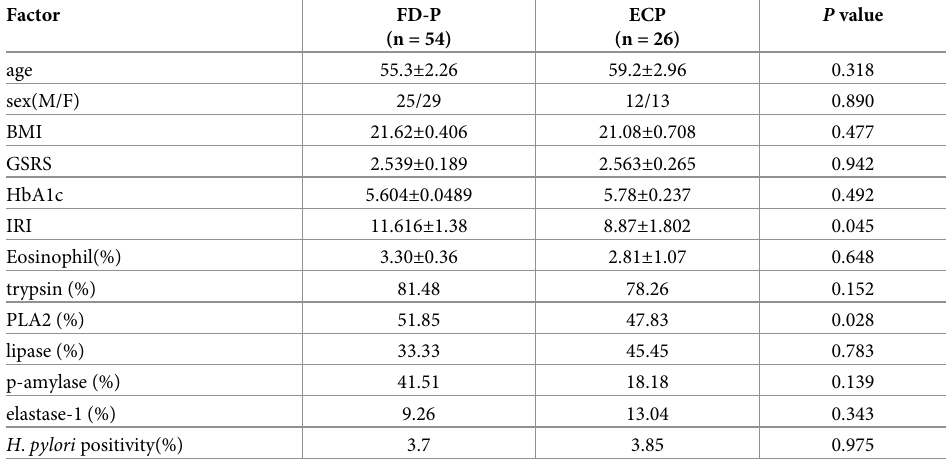
ECP: Early chronic pancreatitis, FD-P: Functional dyspepsia with pancreatic enzyme abnormalities. GSRS: Gastrointestinal Symptom Rating Scale, IRI: Insulin resistance